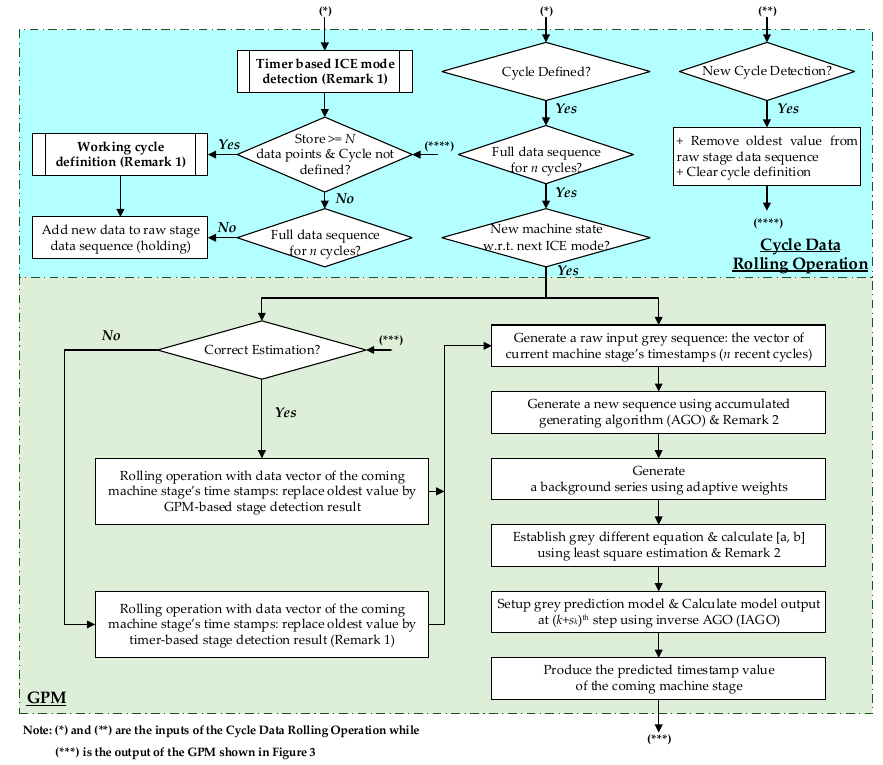
Figure 4. Flow diagram of the cycle data rolling operation and GPM modules in Figure 3 [12].